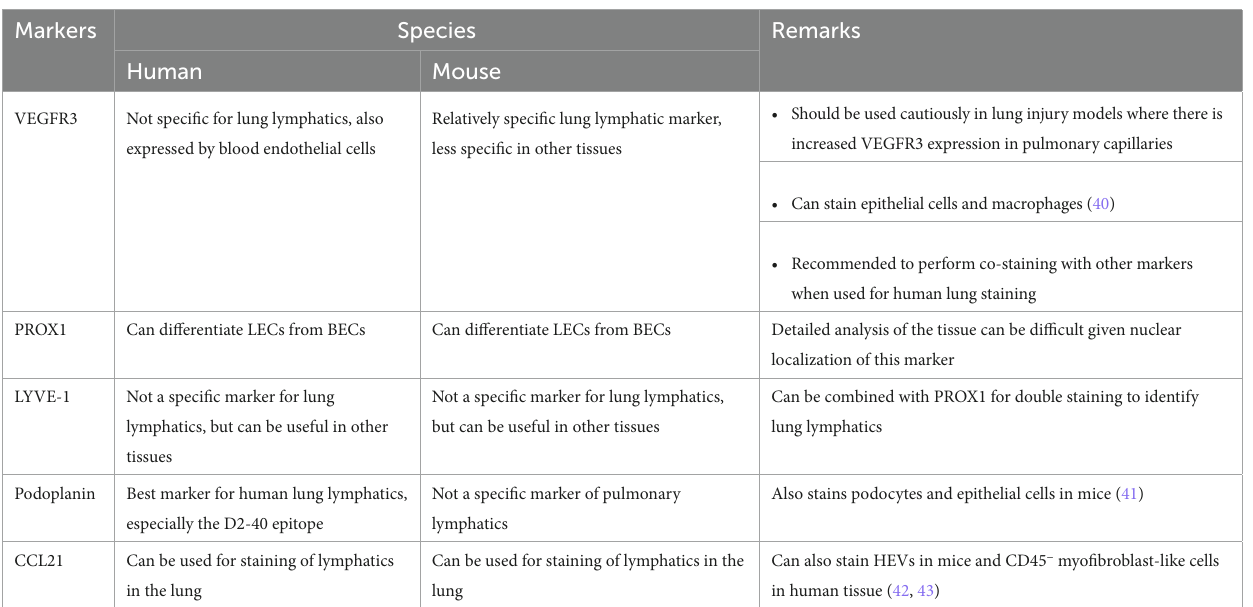
TABLE 1 Lung lymphatic markers in humans and